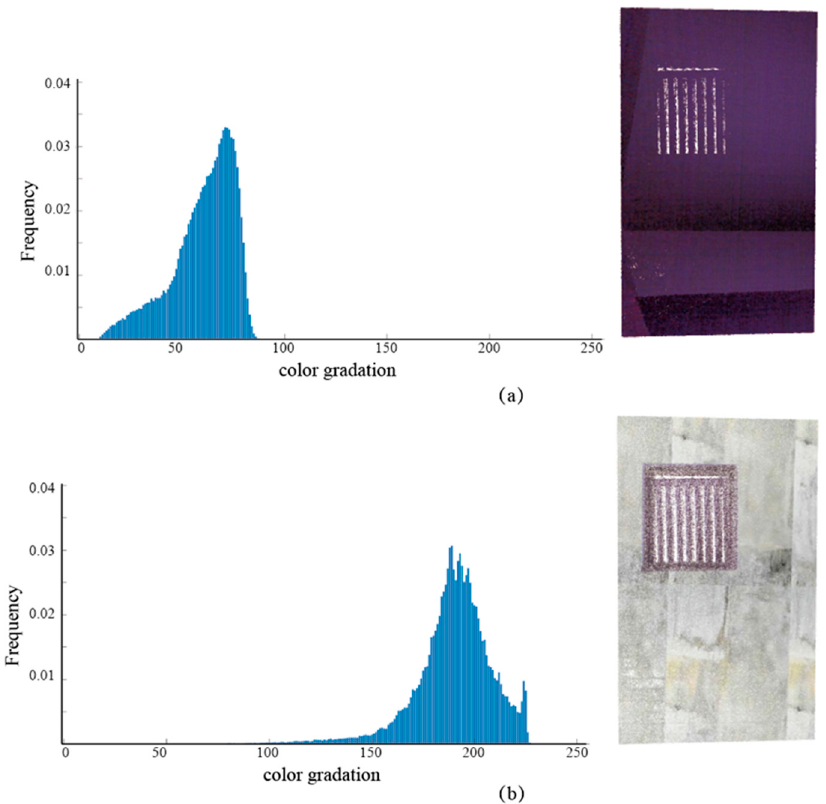
Figure 17. Color histogram of the wall extracted from the Zou Lu House (corresponding to Figure 13).